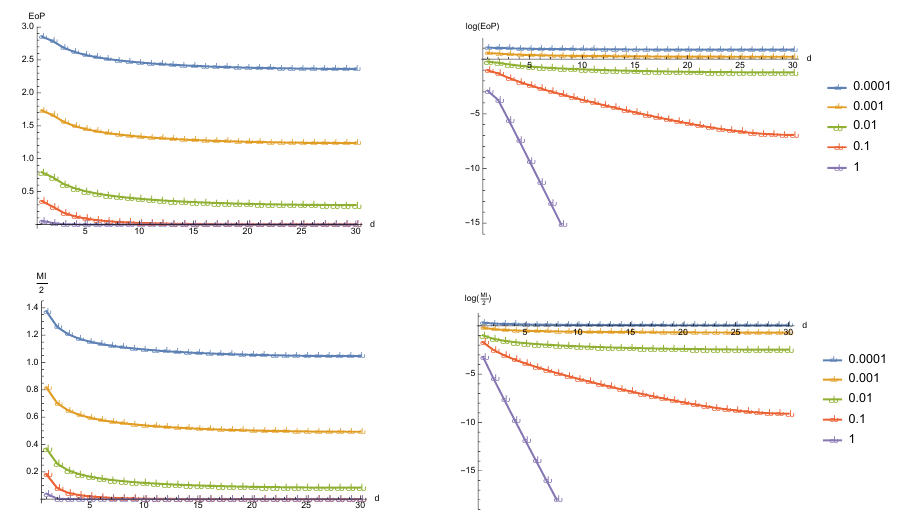
Figure 6 . The plots of EoP (upper-left graphs) and a half of mutual information I ( A : B ) (lower- left graphs) in the setup of j A j = j B j = 1 as a function of d , which is the distance between A and B (we took 1 (cid:20) d (cid:20) 30). The right ones are obtained by taking the logarithms of the left ones. In each graph, from the above to the bottom, the mass varies m = 0 : 0001 ; 0 : 001 ; 0 : 01 ; 0 : 1 ;